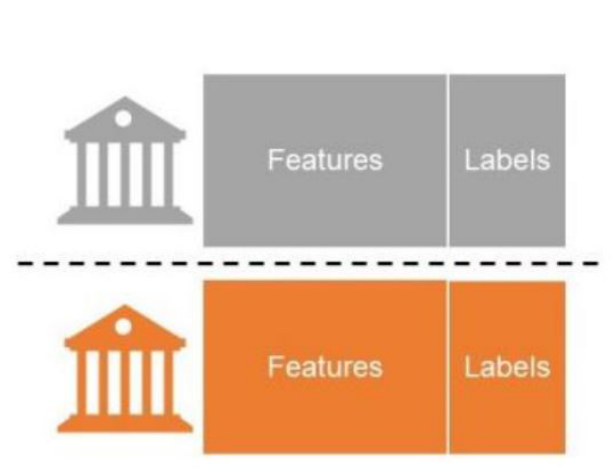
Figure 3. Horizontal FL [37].